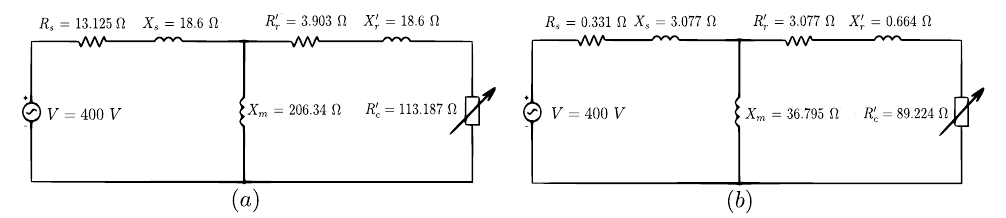
Figure 14. Equivalent circuit per phase. ( a ) Nine-phase IM. ( b ) Three-phase IM. In nominal conditions, the three-phase IM consumes approximately 4500 VAR and has 1560 W power losses. On the other hand, the nine-phase IM consumes 3370 VAR and has 1280 W of power losses in total. This gives approximately 25% reactive power minimization and a reduction of 18% in terms of power losses.